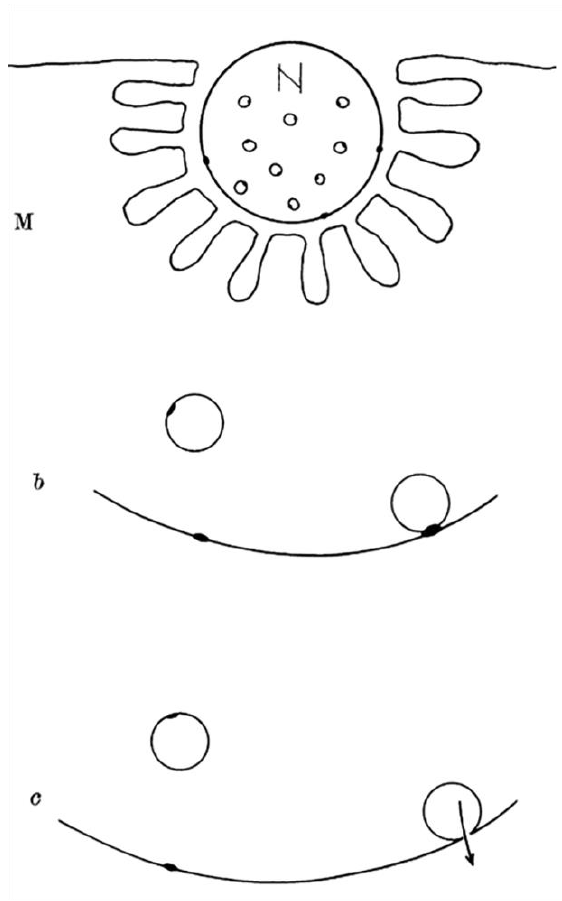
FIGURE 2: Diagram explaining quantal secretion of neurotrans- mitters by exocytosis of synaptic vesicles. Reaction molecules (fusion proteins) are indicated by black dots on vesicular and nerve membranes; a nerve impulse greatly increases the number of reactive sites in the terminal membrane by allowing calcium ions to penetrate it. N, motor nerve terminal; M, end-plate region of a muscle fibre. This scheme was presented by J. del Castillo